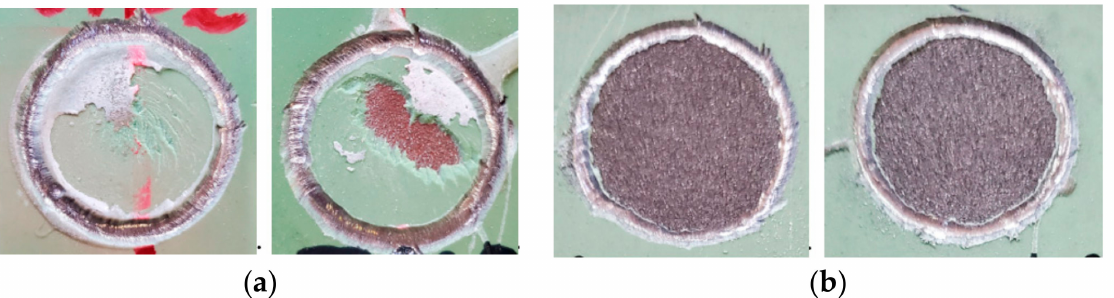
Figure 13. The nature of destruction in the zone after pull-off test: ( a ) witness samples, ( b ) samples after